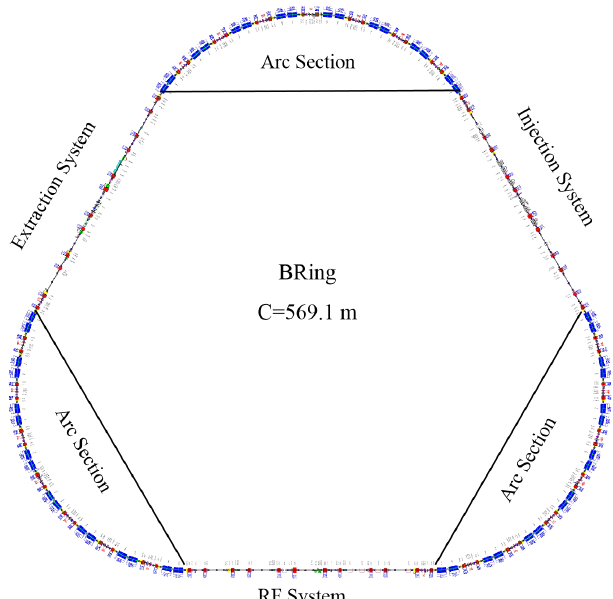
FIG. 1. The general layout of BRing